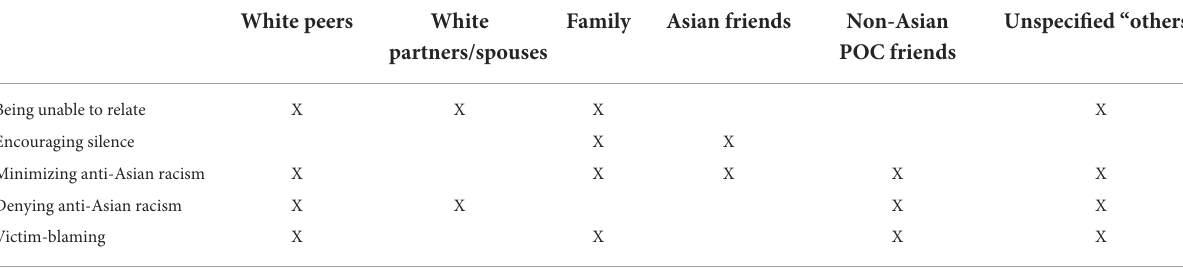
TABLE 1 Experiences of inadequate social support by type and